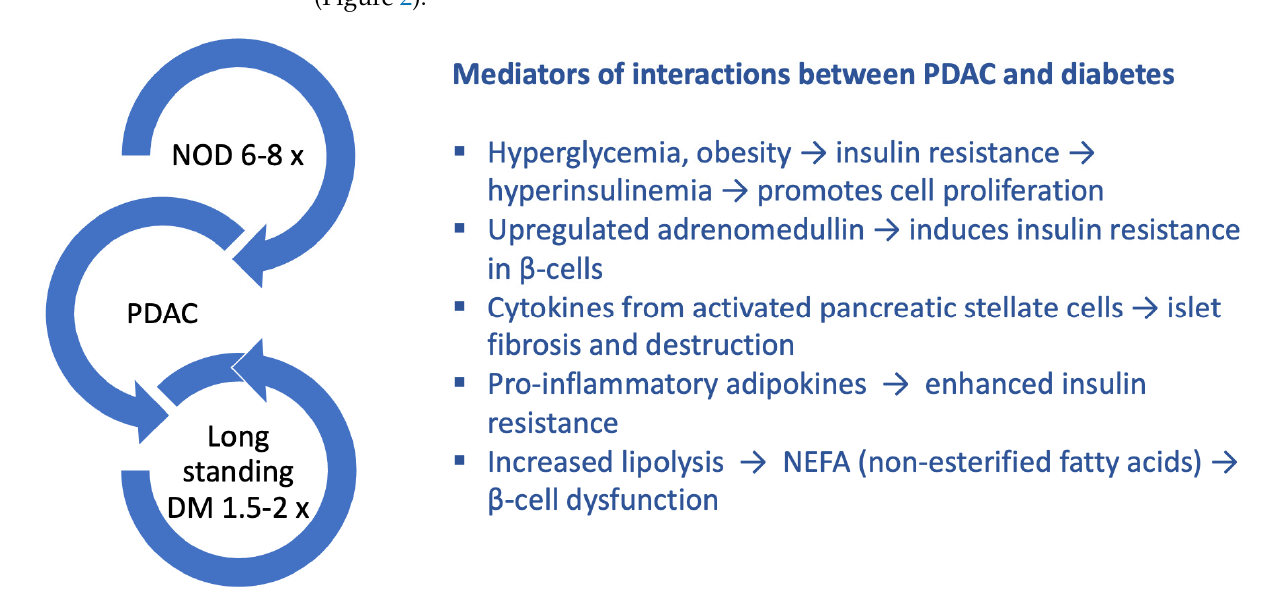
Figure 2. Mediators of interactions between PDAC and diabetes